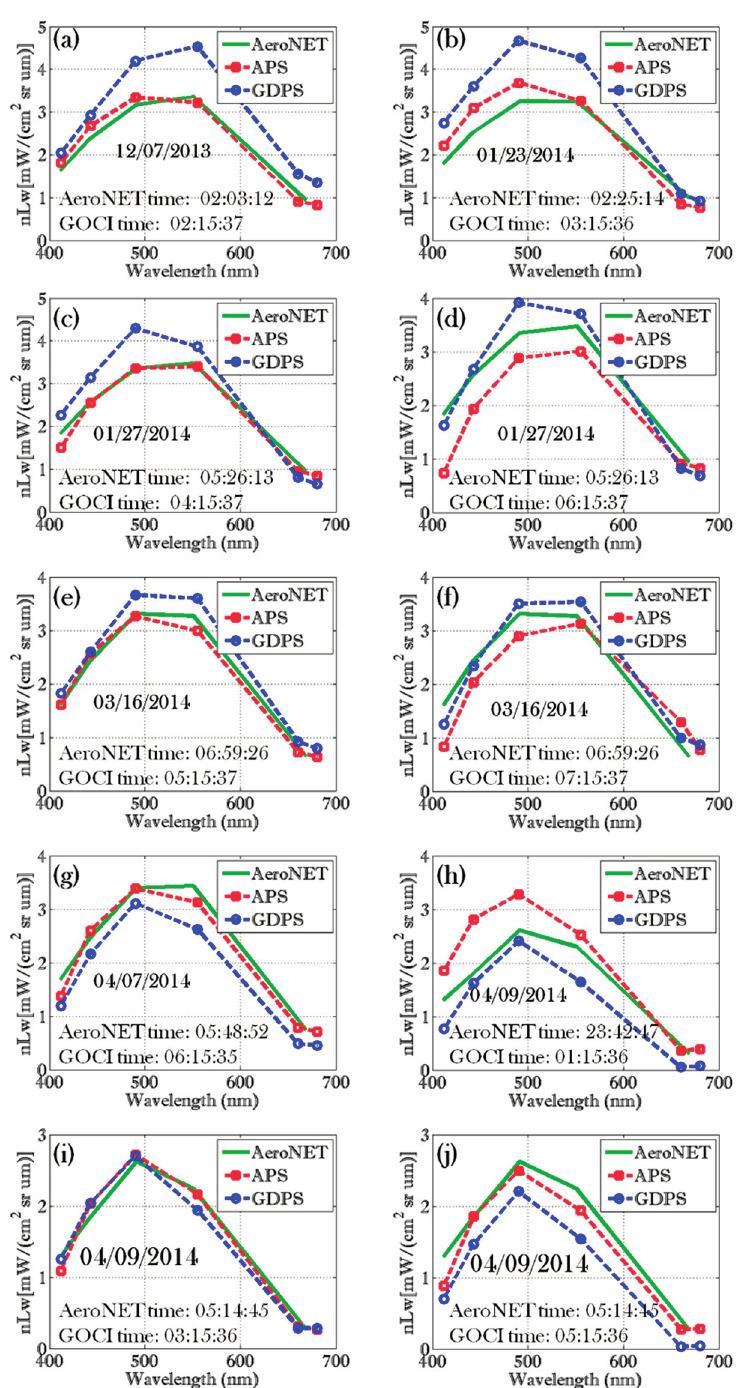
Figure 1. Spectral comparison of nLw at the AeroNET pixel: AeroNET spectra (green), APS retrieved spectra (red), and GDPS retrieved spectra (blue). ( a ) 12/07/2013 GOCI image acquired at 02:15:37 UTC; ( b ) 01/23/2014 GOCI image acquired at 03:15:36 UTC; (c ) 01/27/2014 GOCI image acquired at 04:15:37 UTC; ( d ) 01/27/2014 GOCI image acquired at 06:15:37 UTC, ( e ) 03/16/2014 GOCI image acquired at 05:15:37 UTC; ( f ) 03/16/2014 GOCI image acquired at 07:15:37 UTC; ( g ) 04/07/2014 GOCI image acquired at 06:15:35 UTC; ( h ) 04/09/2014 GOCI image acquired at 01:15:36 UTC; ( i ) 04/09/2014 GOCI image acquired at 03:15:36 UTC; and ( j ) 04/09/2014 GOCI image acquired at 05:15:36